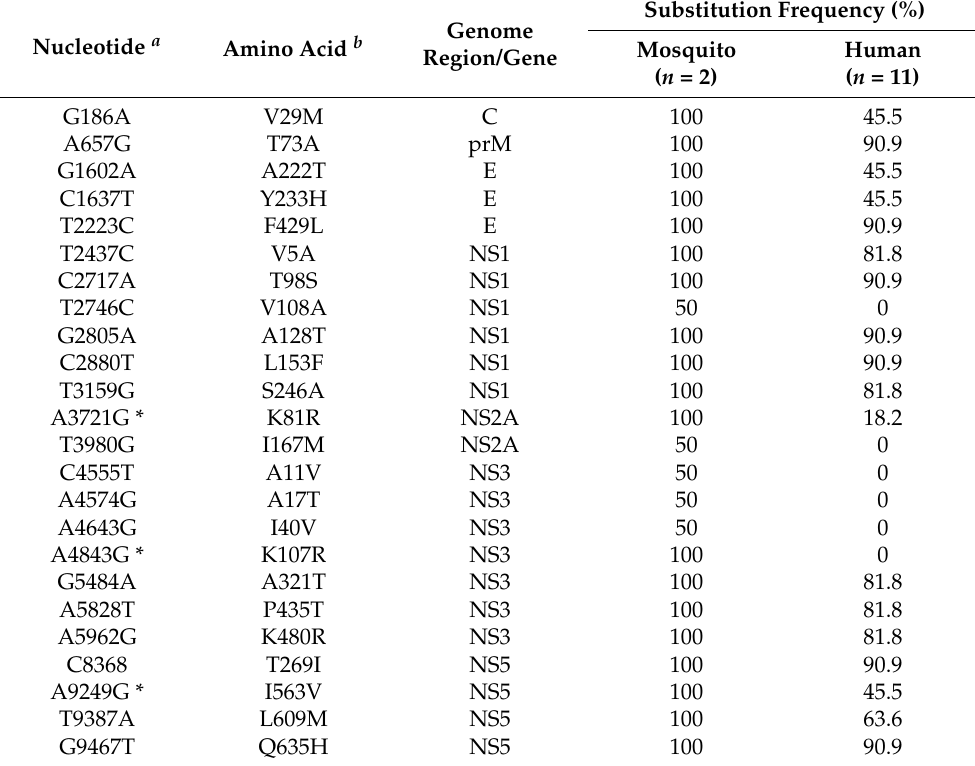
Table 2. Sequence disparities between DENV-4 genomes in mosquito and human hosts.